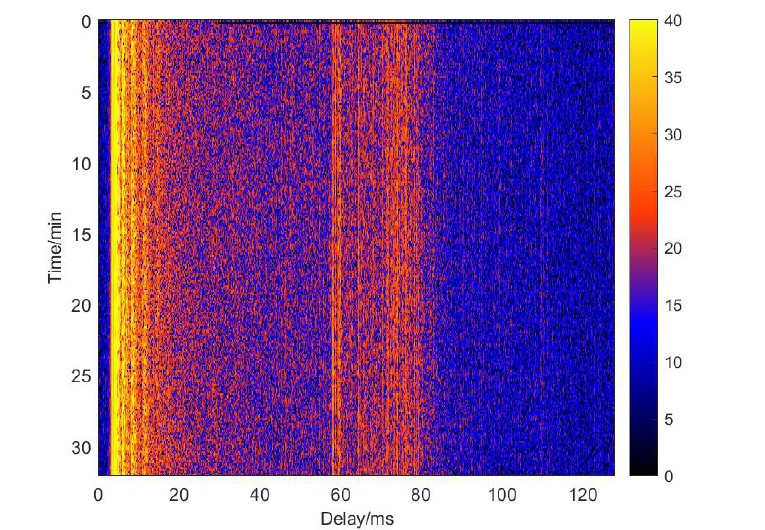
Figure 7. CIR in time domain under NOF